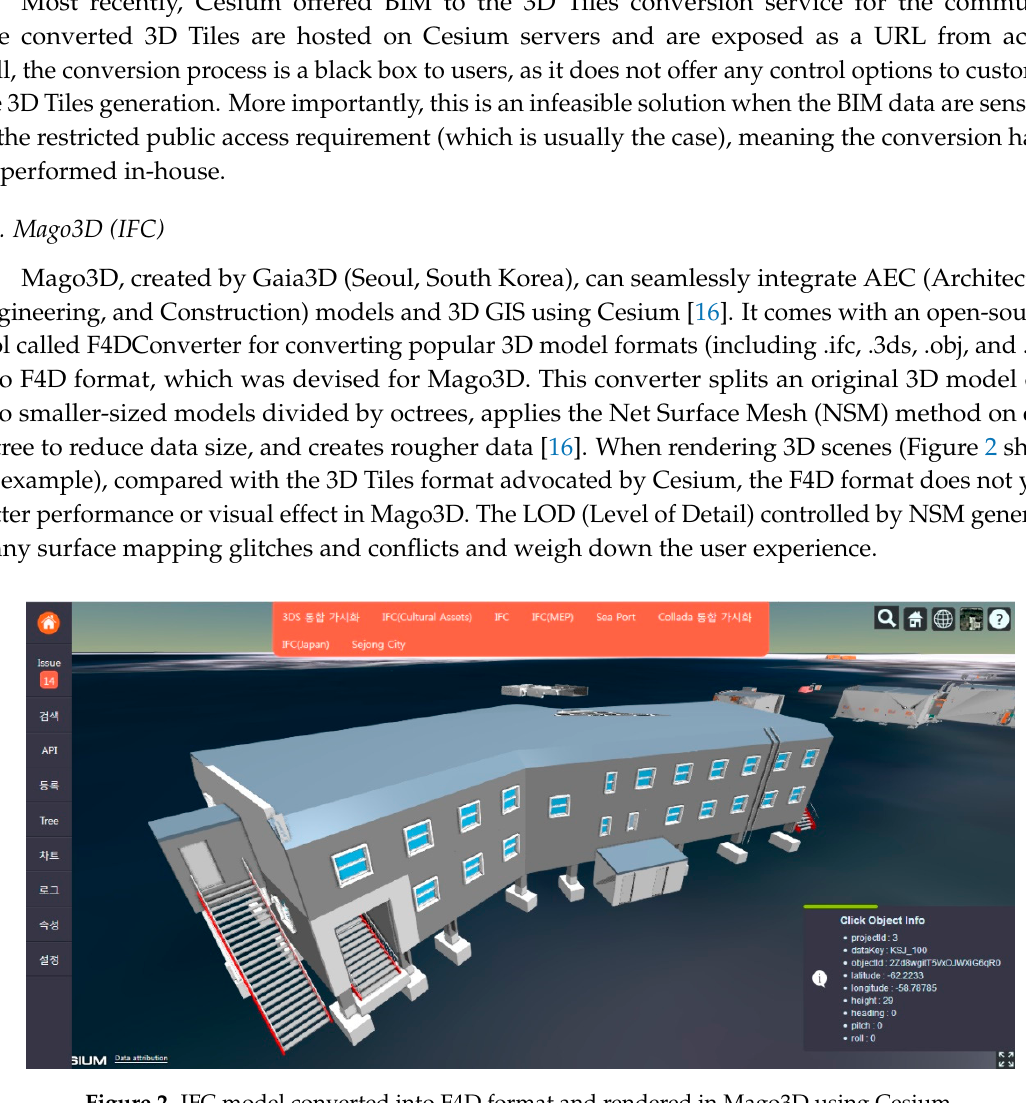
Figure 2. IFC model converted into F4D format and rendered in Mago3D using Cesium.